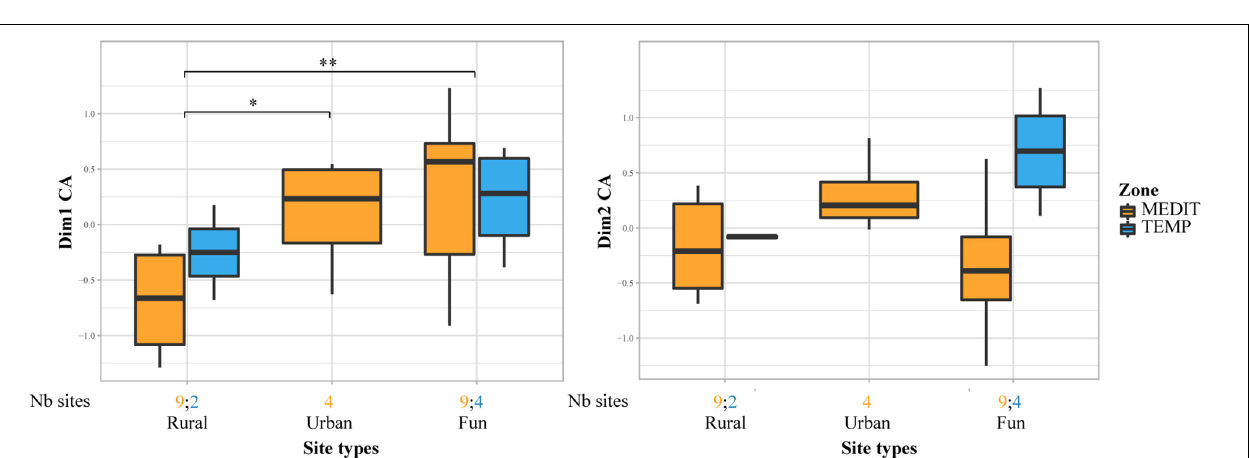
FIGURE 6 | Comparison of site types for the Neolithic and Bronze Age periods. Cave sites are opposed to open air settlements (rural and village sites). Box plots showing the distribution of sites on axis 1 and 2 of the CFA performed on charred fruit remains in relation to site types and bioclimatic zones. Statistical significances of the Wilcoxon tests are indicated on the box plots, only when the result is significant ( ∗ p ≤ 0.05). The number of sites for each site category and bioclimatic zone is provided at the bottom of the graph.